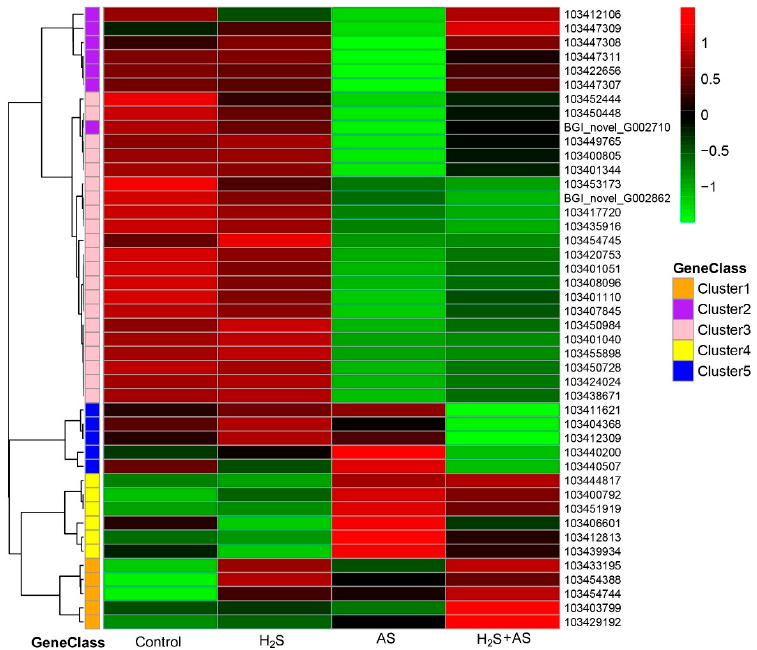
Figure 6. H 2 S-mediated expression of ROS-defense-related genes under alkaline salt stress in M. hupehensis root. For the examination of the expression profiles of genes that responded to H 2 S and alkaline salt treatment in M. hupehensis roots, we randomly selected four sulfur-containing compounds, one reactive oxygen metabolism, three cell wall metabolism, and two energy metabolism genes for PCR verification. We found that these genes correlated well with the results achieved by RNA-seq analysis (Figure 8). Therefore, the qRT-PCR results demonstrated that the RNA-seq data were reliable. Actin was used for the data normali- zation of the reference genes. The primers of the selected genes are shown in Table S1.